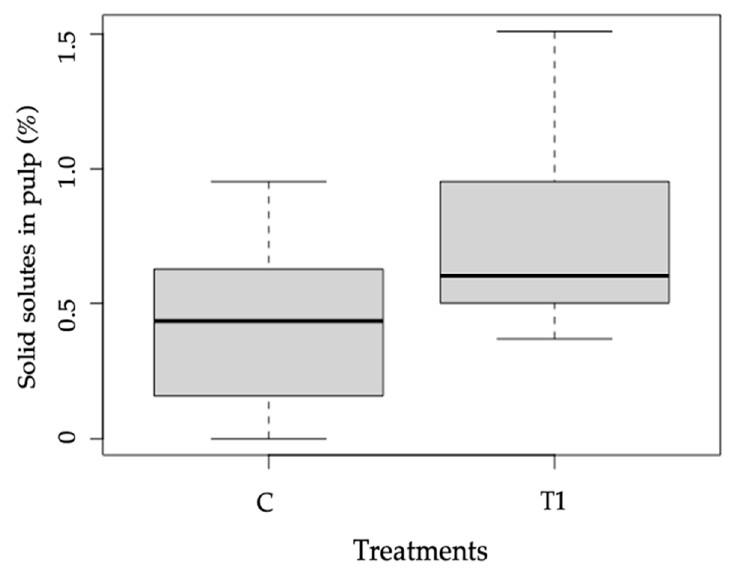
Figure 4. Percentage of solid solutes in the pulp of fruits of Cucurbita maxima var. Paine in both plots under floral patches addition treatment. C = control, T1: Treatment 1.